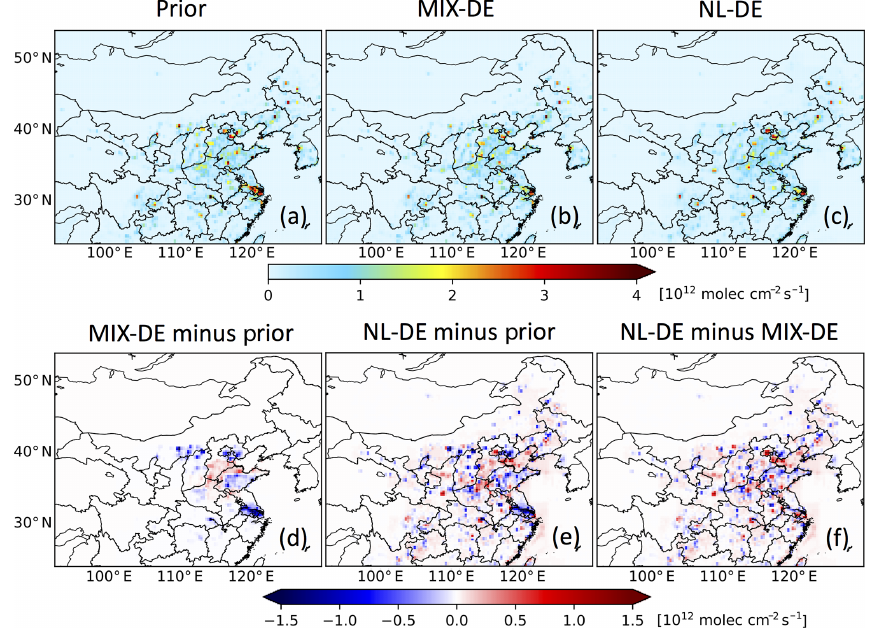
Figure 9. NO x 0 . 25 ◦ × 0 . 3125 ◦ emissions of prior MIX 2010 (a) , posterior MIX-DE (b) , posterior NL-DE (c) , the difference between posterior MIX-DE and prior MIX 2010 (d) , the difference between posterior NL-DE and prior MIX 2010 (e) , and the difference between posterior NL-DE and posterior MIX-DE (f) .